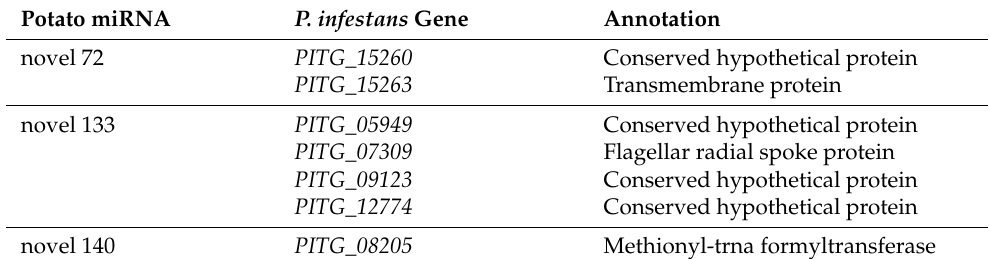
Table 3. Predicted P. infestans genes only targeted by three potato-derived